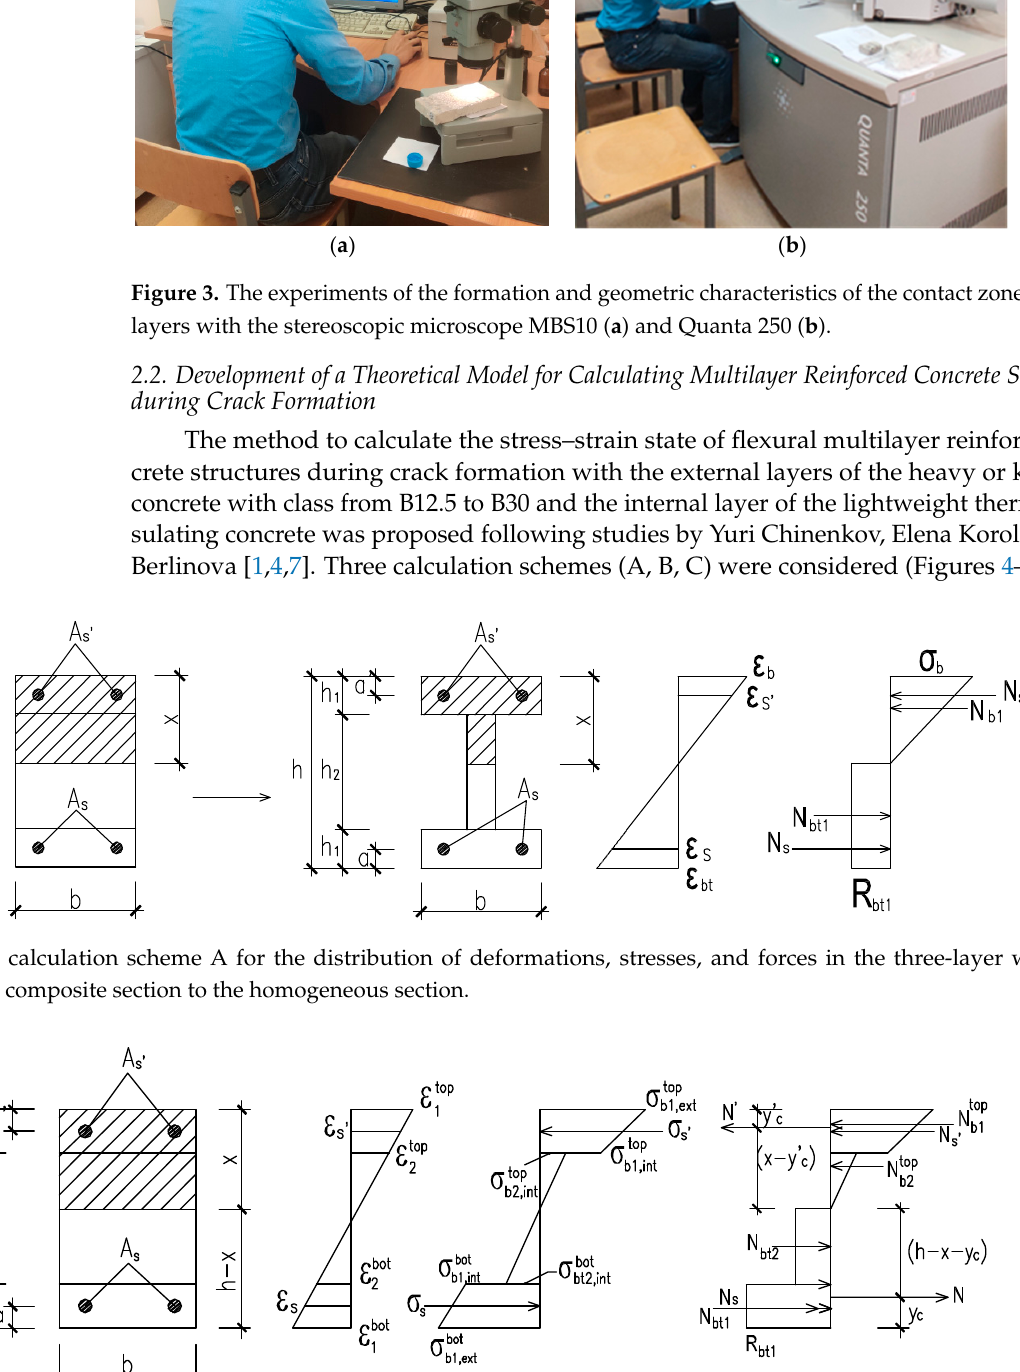
Figure 6. The calculation scheme C for the distribution of deformations, stresses, and forces in the three-layer, taking into account the contact interlayers. (i) The method of converting the composite cross-section to a homogeneous cross- section T-beam or I-beam was proposed for calculating deformations and stresses of multilayer structures with a heat-insulating layer in the middle cross-section of structures. This design scheme is starting now referred to as scheme A (Figure 4). Scheme A has not taken into account the different values of the compressive and tensile strength of concrete of the external and middle layers in the tensile and compressive zone of the cross-section. (ii) The calculation of the formation of the crack normal to the longitudinal axis of multilayer structures is made in Scheme B (Figure 5). Scheme B assumes that before cracks formation, the stresses in the compressed zone's concrete are determined with the account of elastic deformations, and stresses reach the limit of the tensile resistance of the concrete in the stretched zone. The forces perceived by the normal cross-section in the limiting state before the formation of cracks are determined based on the following provisions: - the cross-sections after deformation remains flat, i.e., the deformations in the height of the element change according to Hook's law; - the maximum value of elongation stretched extreme fiber of concrete is equal to bt b1 R 2 E ; - the stress in the concrete compressed zone is determined by the elastic deformation of the concrete in the corresponding layer; - the stresses at the boundary line of two concrete layers are different for each concrete layer due to the different modules of elasticity; - stress in the concrete stretched zones is evenly distributed within each layer and equal to the axial tensile resistance of the concrete of the external layer s Rbt1 and internal layers R bt 2, respectively;